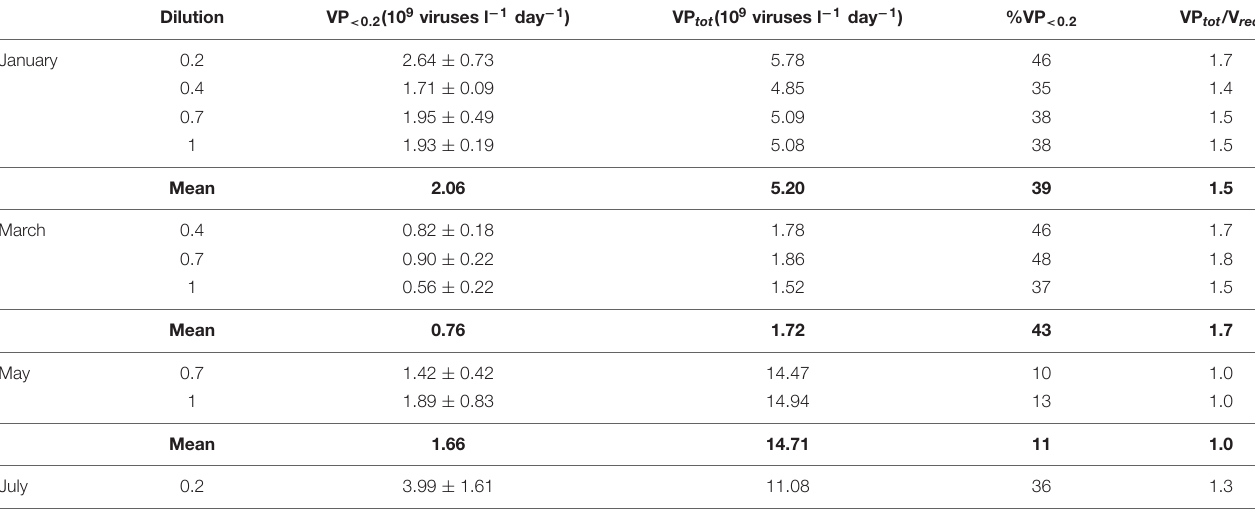
TABLE 3 | Comparison among VP in the < 0.2- µ m filtrate (VP < 0 . 2 ), VP estimated from the virus reduction assay (VP red ), and total VP (VP tot ).